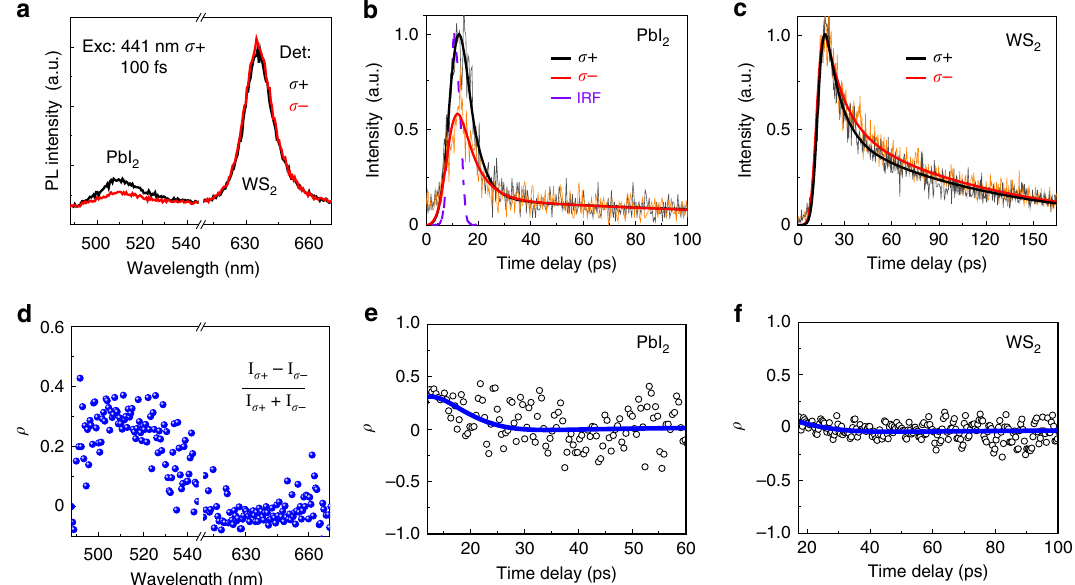
Fig. 3 Spin polarization dynamics of PbI 2 /WS 2 heterostructures. a – c Circularly polarized PL spectra ( a ) and TRPL data from PbI 2 ( b ), and WS 2 ( c ) of PbI 2 /WS 2 heterostructures. d – f Corresponding degree of polarization ρ as a function of wavelength and time calculated from the PL and TRPL spectra. For excitation, a 441 nm σ + polarized fs-pulsed laser beam was these two time-resolved polarized PL decays, we can calculate the degree of polarization as a function of time, revealing the polar- ization lifetime of about 15 ps (Fig. 3e). For resonance excitation, the polarization lifetime is expected to be longer 45 , which could lead to a higher degree of polarization due to a smaller τ c / τ s .